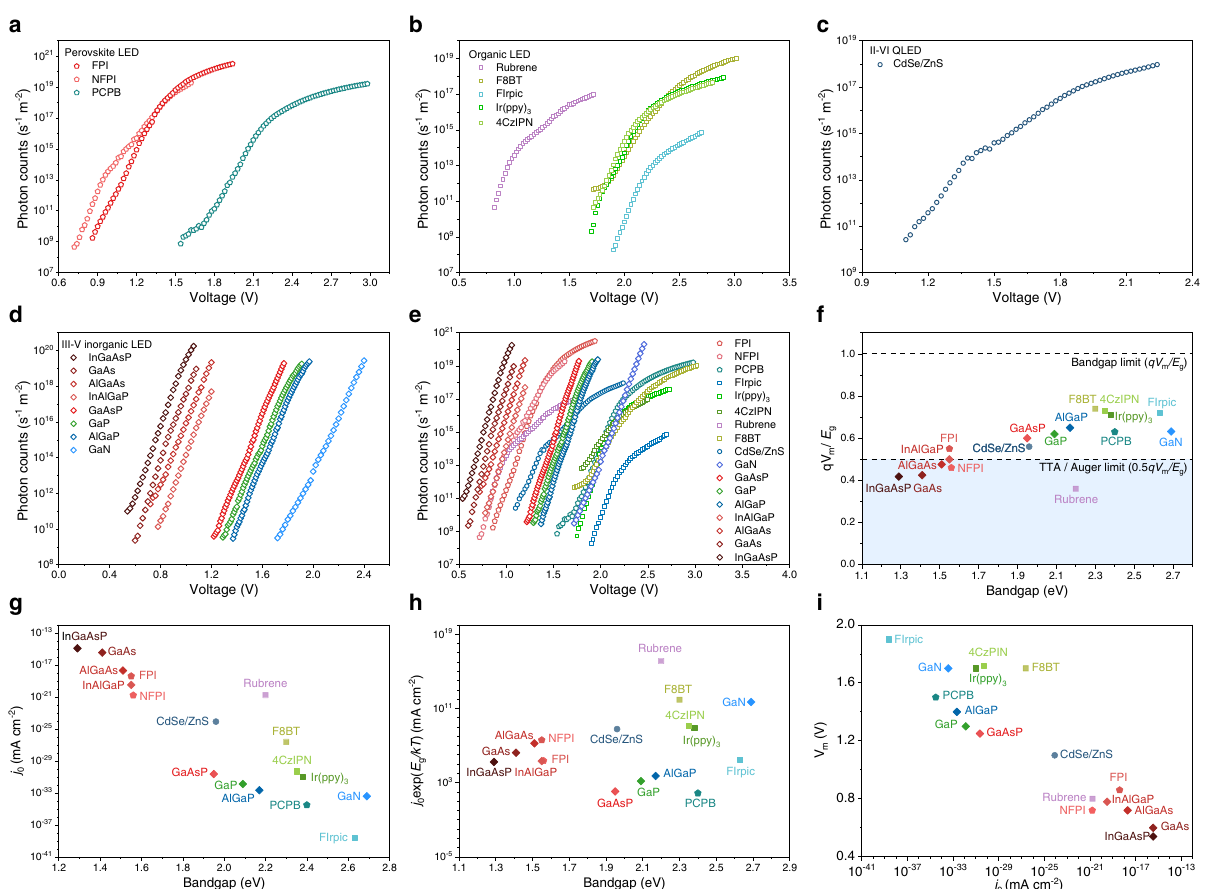
Fig. 3 EL intensity-voltage characteristics at near- and sub-bandgap voltages for different LEDs. a Perovskite LEDs based on FPI, NFPI and PCPB. b Organic LEDs based on Ir(ppy) 3 , FIrpic, 4CzIPN, rubrene and F8BT. c II – VI QLED based on CdSe/ZnS QDs. d III – V inorganic LEDs based on InGaAsP, GaAs, AlGaAs, InAlGaP, GaAsP, GaP, AlGaP and GaN. e Collection of EL intensity-voltage curves for different classes of LEDs in the same panel. f Measured qV m / E g of different classes of LEDs. The shaded area denotes the region where the measured qV m / E g falls below the limits set by TTA or Auger processes. g Dark saturation current densities ( j 0 ) of different classes of LEDs. h j 0 exp( E g / kT ) of different classes of LEDs. i V m versu j 0 for different classes of LEDs. V m is the measured minimum voltage for detectable EL. Table 1 Measured minimum operating voltages of different LEDs studied in this work. Device